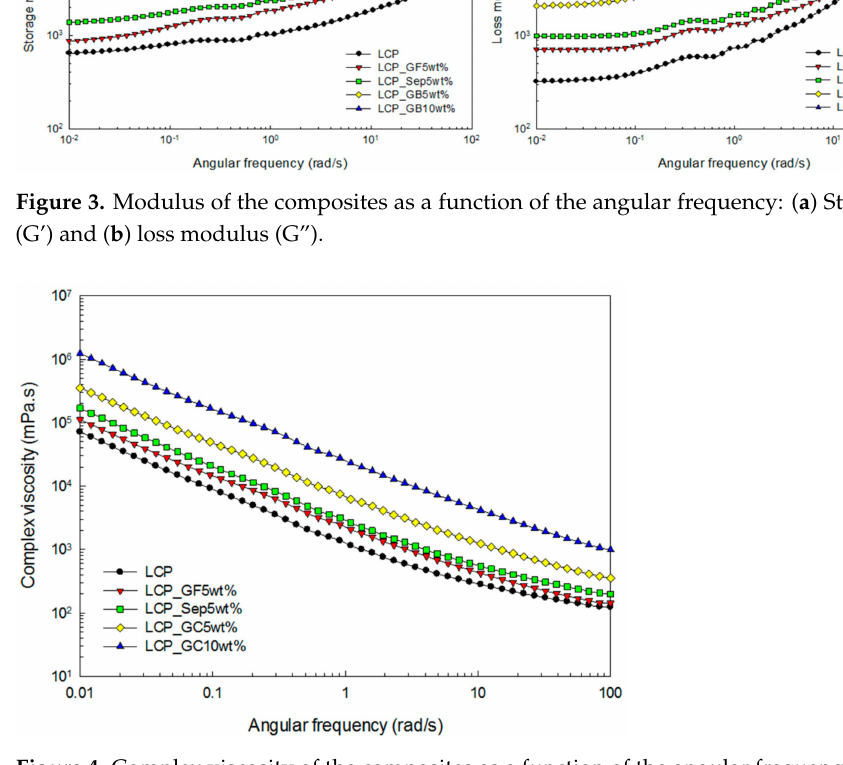
Figure 4. Complex viscosity of the composites as a function of the angular frequency.